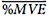
Histogram of incidence of isometric contractions (MM) in the contralateral hand defined by a score consisting of the correlation of the electromyography (EMG) signal measured at the extensor muscles of the contralateral hand during the task with the task boxcar multiplied by the average % of maximal voluntary contraction (%MVE¯) (measured before the session in the scanner) of the muscle during the session.Patient-scores are depicted in black. Control-scores are depicted in grey.